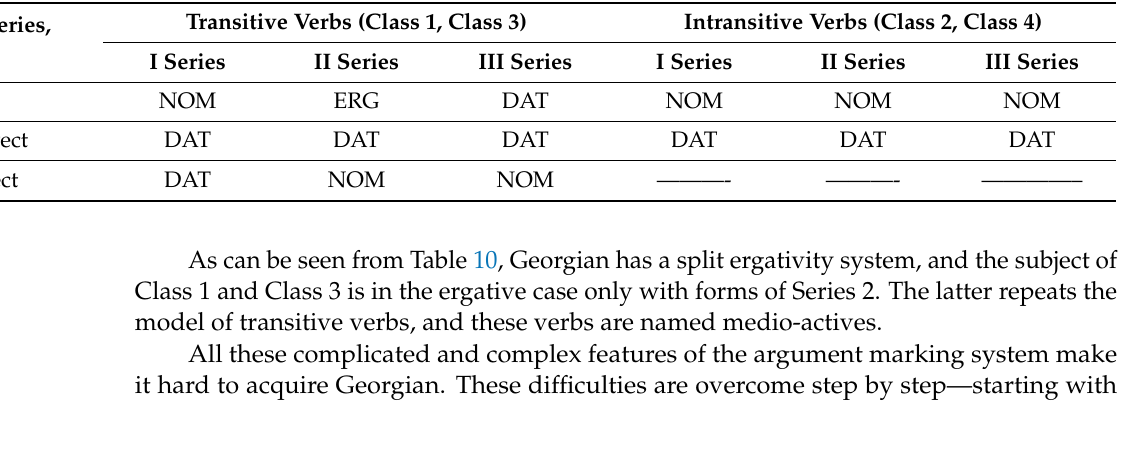
Table 10. Cases of